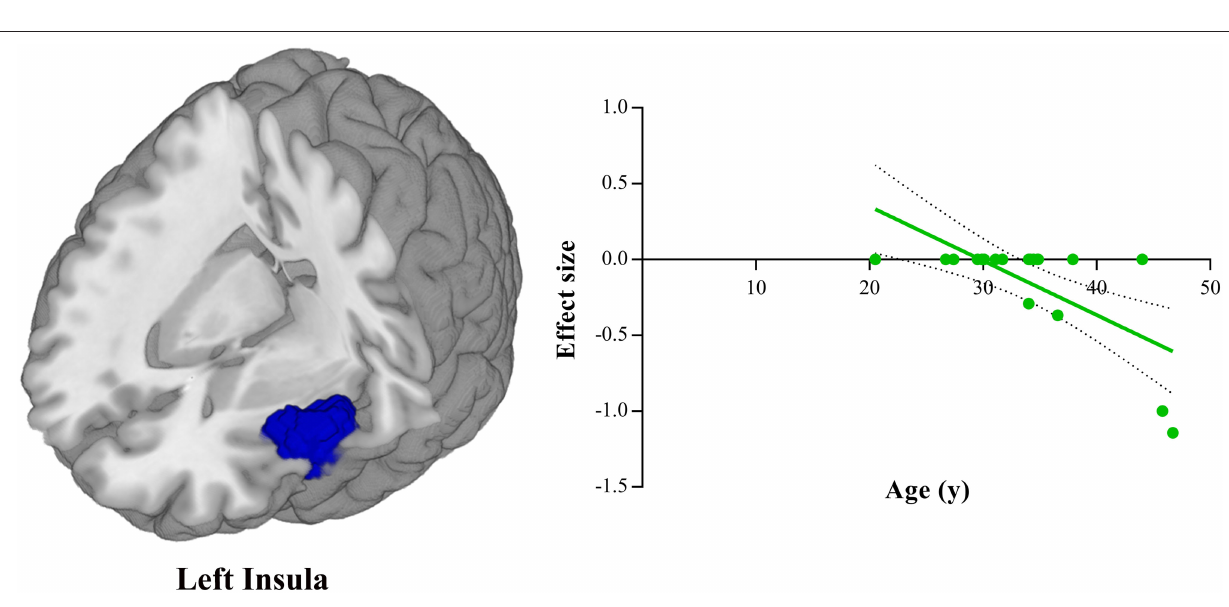
FIGURE 4 | Meta-regression analysis shows that mean age of depressed patients is negatively correlated with gray matter volume in the left insula. In the graphs, the effect sizes needed to create this plot have been extracted from the peak of maximum slope significance, and each study is represented as a dot. The regression line (meta-regression signed differential mapping slope) is